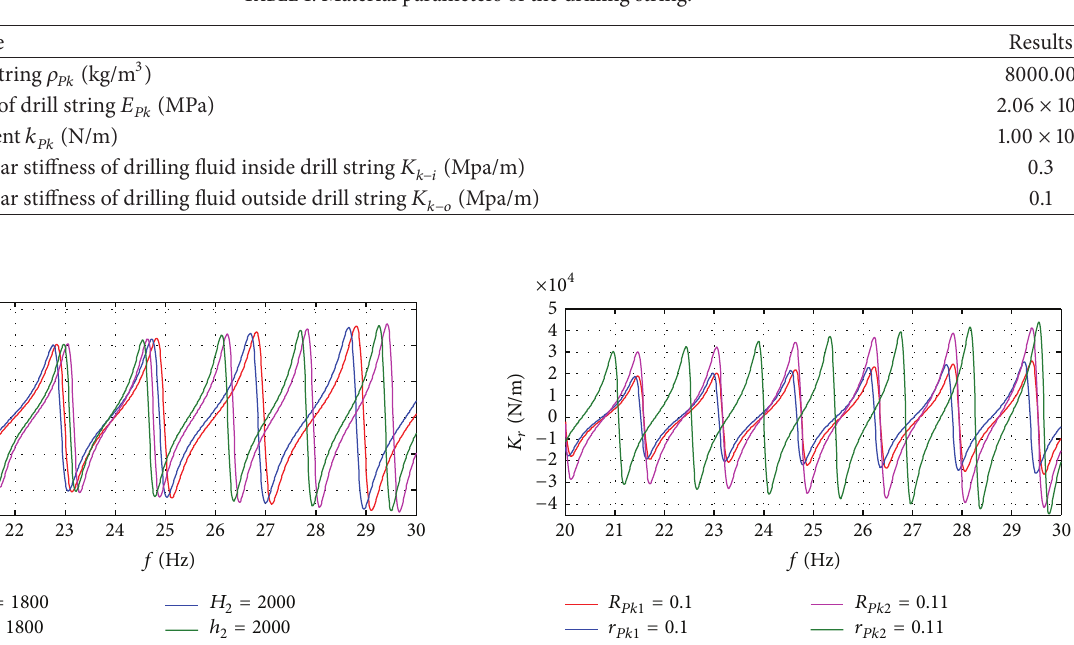
Table 1: Material parameters of the drilling string.